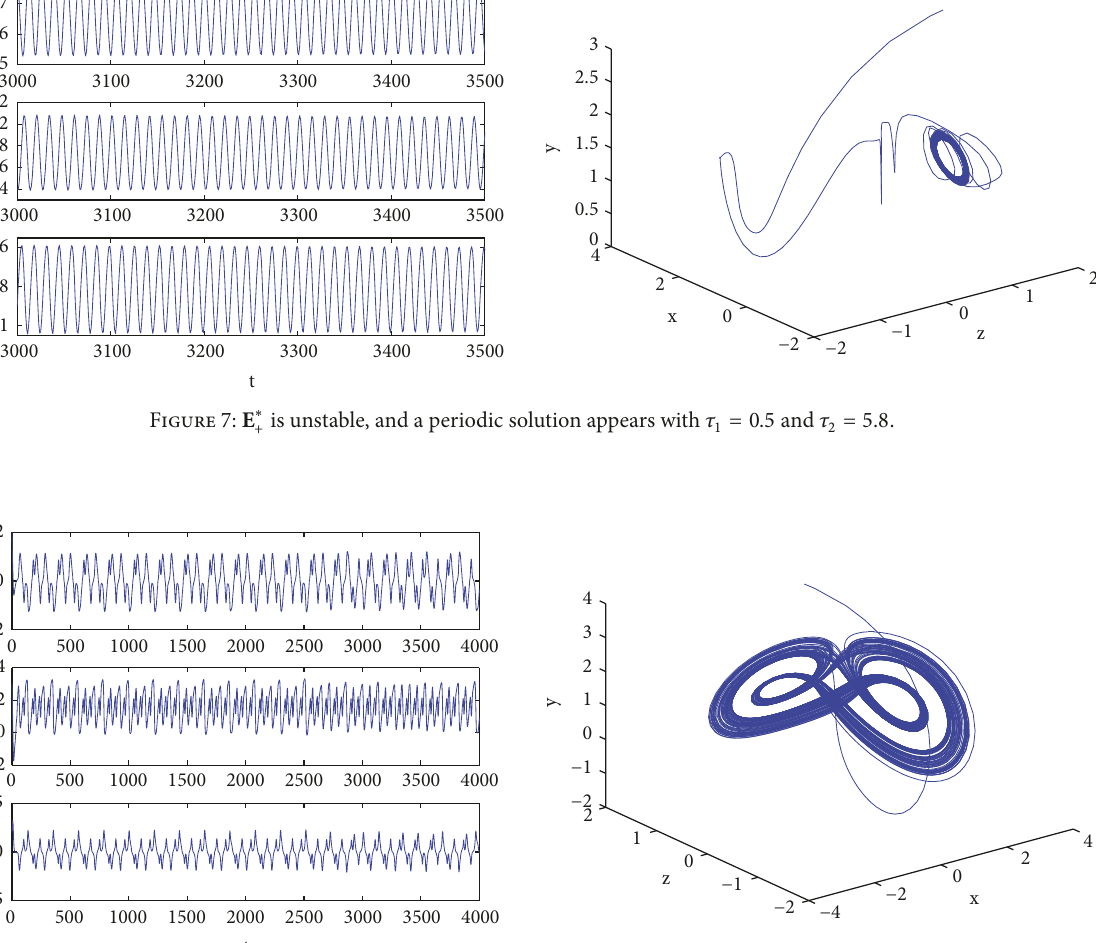
Figure 8: E ∗ + is unstable and chaos exists with 𝜏 1 = 0.1 and 𝜏 2 = 0.1